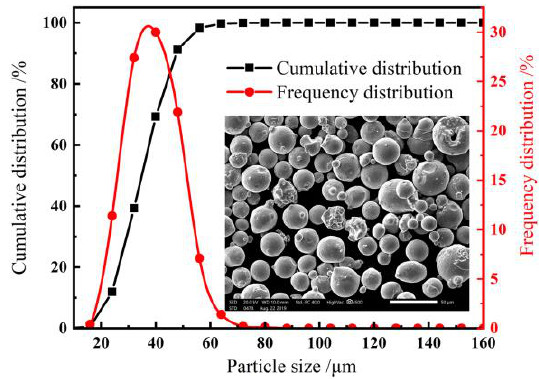
Figure 1. SEM morphology and particle size distribution of Hastelloy-X nickel base superalloy powder.